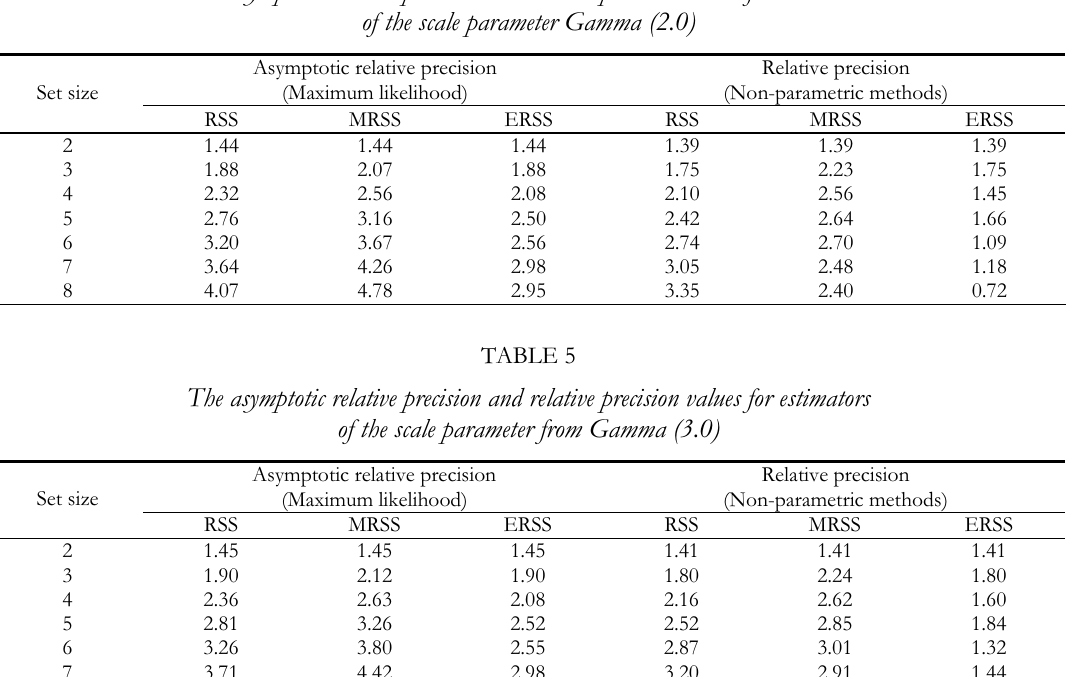
Relative precision (Non-parametric methods) Set size